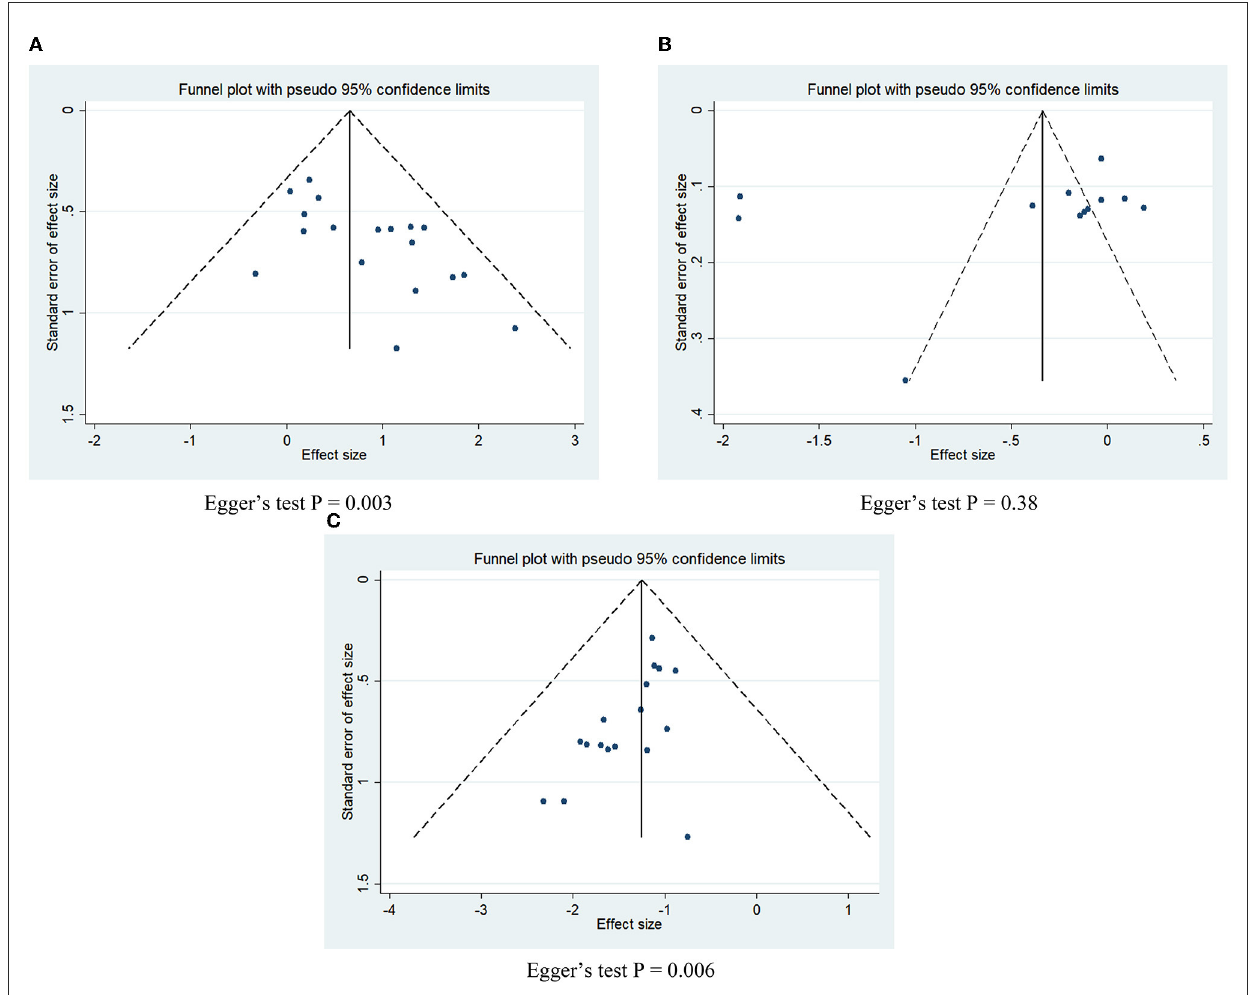
FIGURE6 Funnel plots and Egger’s test for potential publication bias. (A) Effective rate; (B) VAS score; (C) adverse event